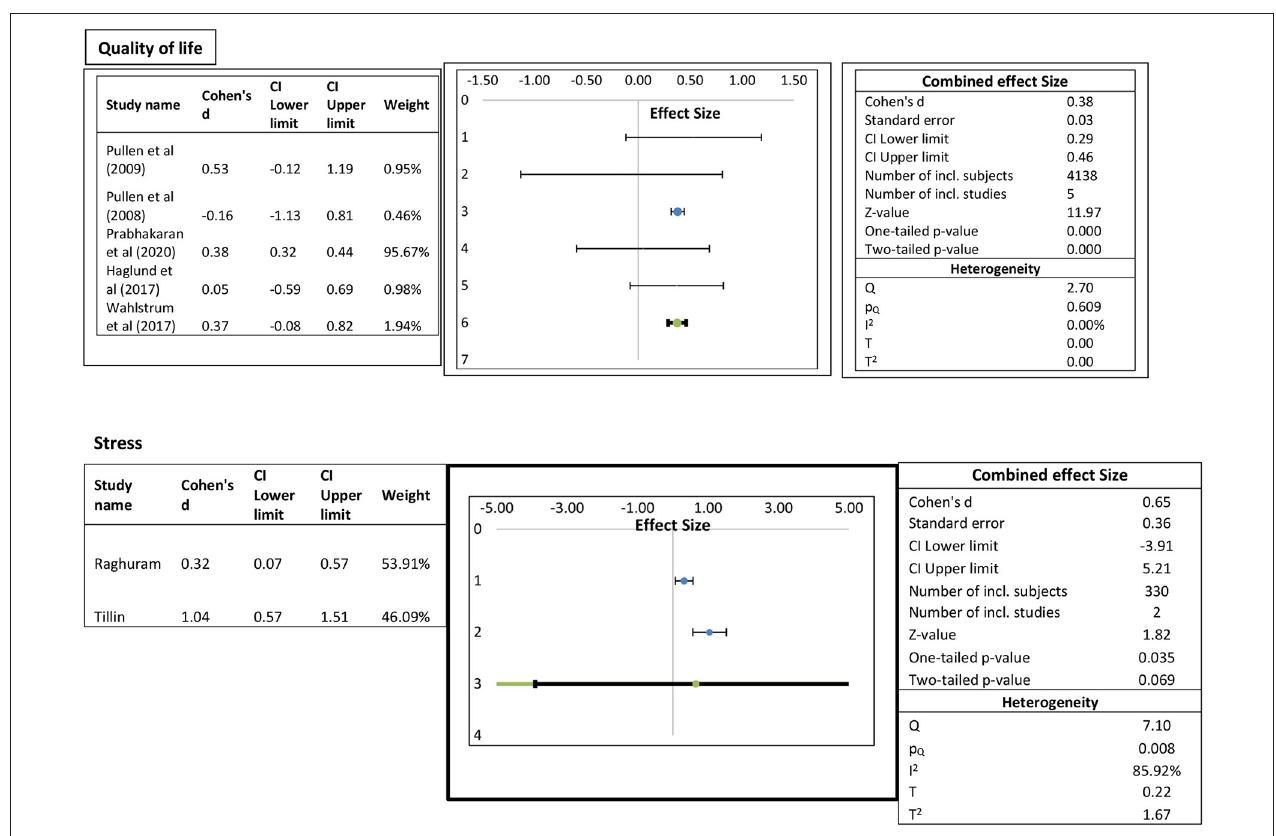
FIGURE 2 | Forest plots of the effect of yogic interventions on physiological and psychosocial